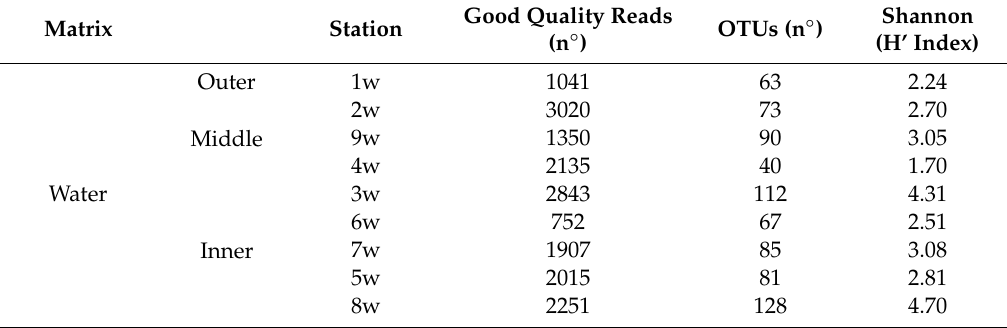
Figure 2. Venn diagrams showing unique and shared OTUs ( a ) among water samples by sampling zone, ( b ) among sediment samples by sampling zone, and ( c ) among all samples by sampling zone. The number of OTUs per sampling site is in bracket. Table 2. Number of good quality reads, OTUs, and Shannon diversity index obtained after row data analysis for each sampling station. Stations sampled for both sediment and water are in